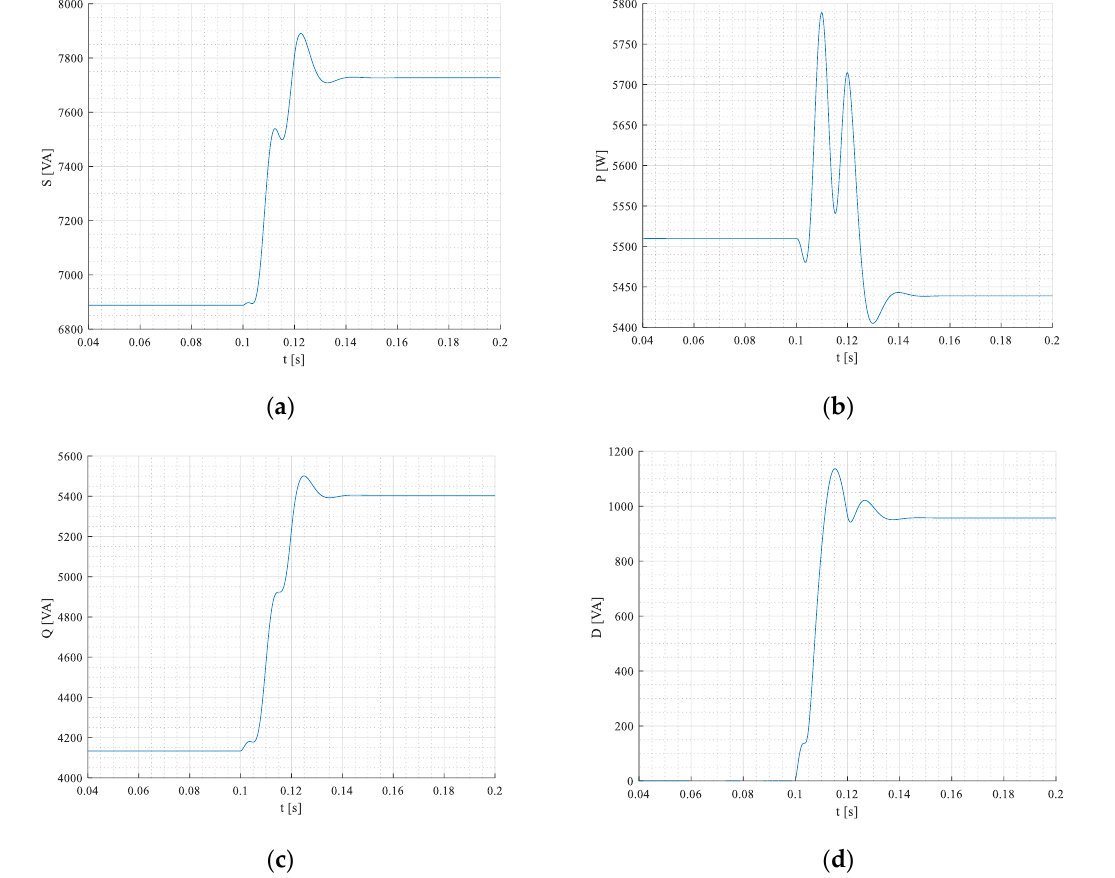
Figure 27. Apparent-( a ), active-( b ), blind-( c ), and distortion ( d ) power components during transient states for 3-phase system under a symmetrical network supplying non-symmetrical linear RL load.